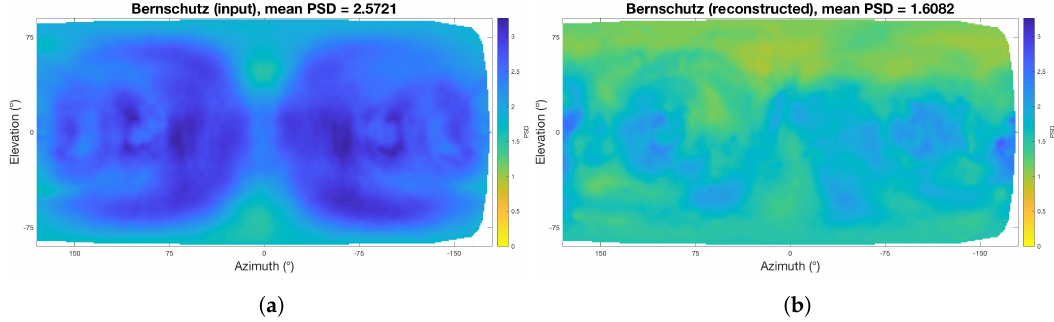
Figure 16. Comparing the PSD of Bernschutz KU100 dataset before and after reconstruction, which shows a noticeable improvement in most regions. ( a ) Before Reconstruction. ( b ) After